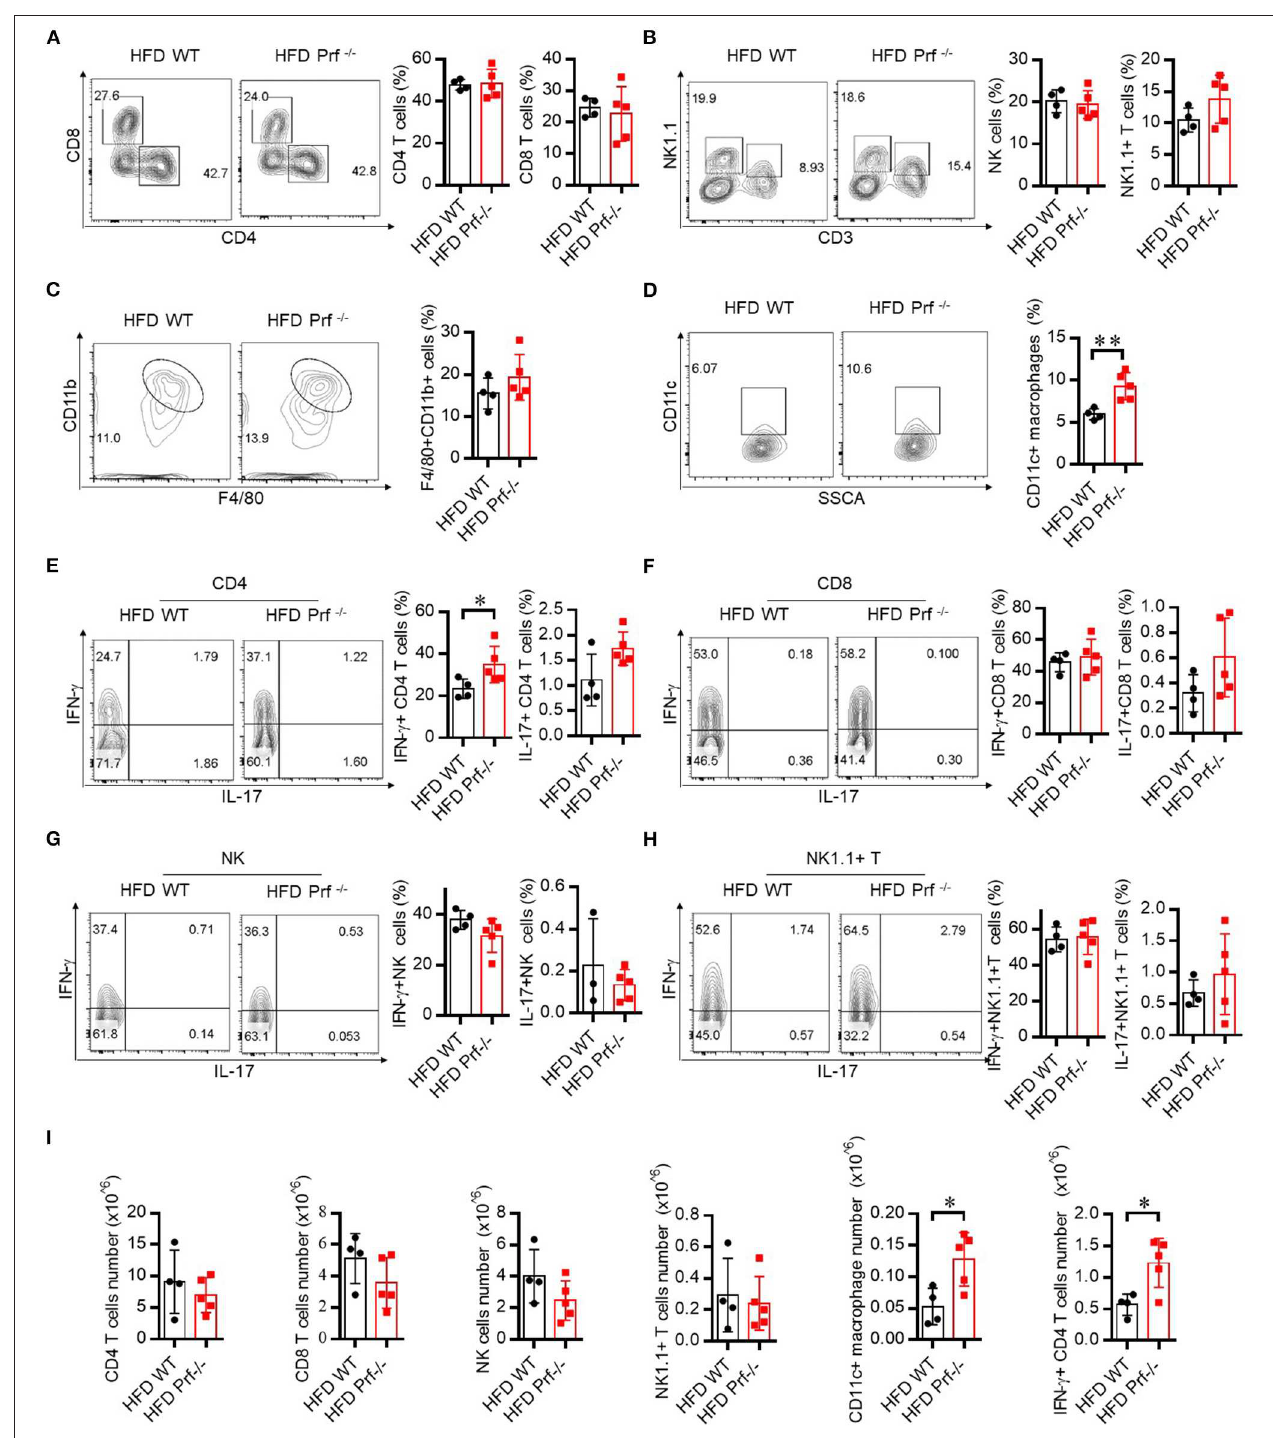
FIGURE 3 | Perforin deficiency drives inflammatory reactions in liver after HFD challenge. WT and Prf − / − mice were fed HFD for 10 weeks. Flow cytometry analysis of the representative histogram (left) and frequency (right) of liver CD4T cells, CD8T cells (A) , NK cells, NK1.1 + T cells (B) , macrophages (C) , and CD11c + macrophages (D) and intracellular staining in the liver for IFN- γ and IL-17 in CD4T cells (E) , CD8T cells (F) , NK cells (G) , and NK1.1 + T cells (H) . (I) The total number of CD4T cells, CD8T cells, NK cells, and NK1.1 + T cells, CD11c + macrophages and IFN- γ + CD4T cells. n = 4–5 mice per group. The data shown in each panel of the figures were collected from a single experiment, and each experiment was repeated for at least three times and rendered consistent results. Means ± SEM; * p < 0.05.